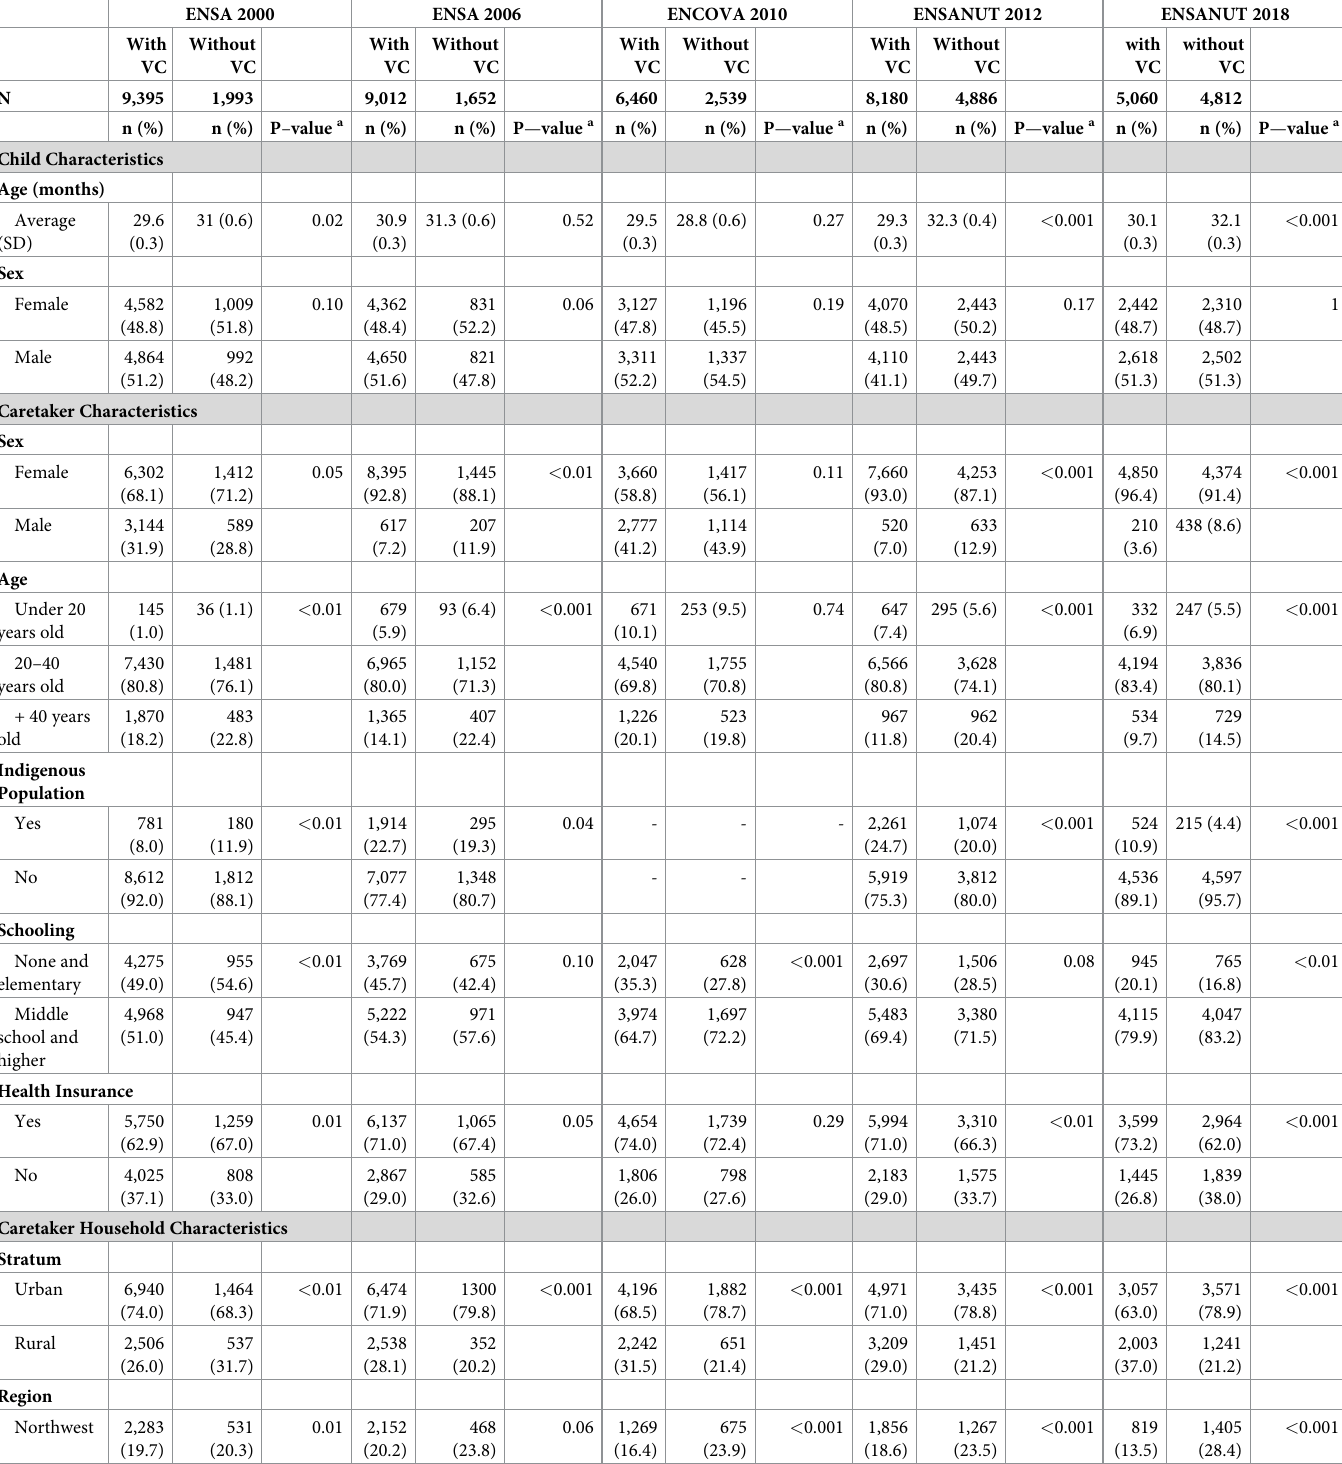
Table 2. Socio-demographic characteristics comparison of the caretaker and the child between the groups with and without VC, according to national health surveys. ENSA 2000 ENSA 2006 ENCOVA